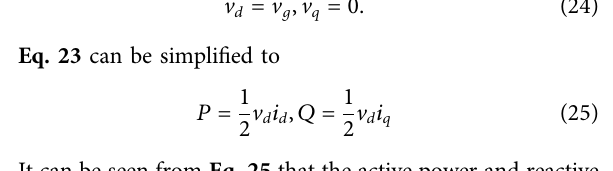
voltage and current phase angle difference of the smart inverter.